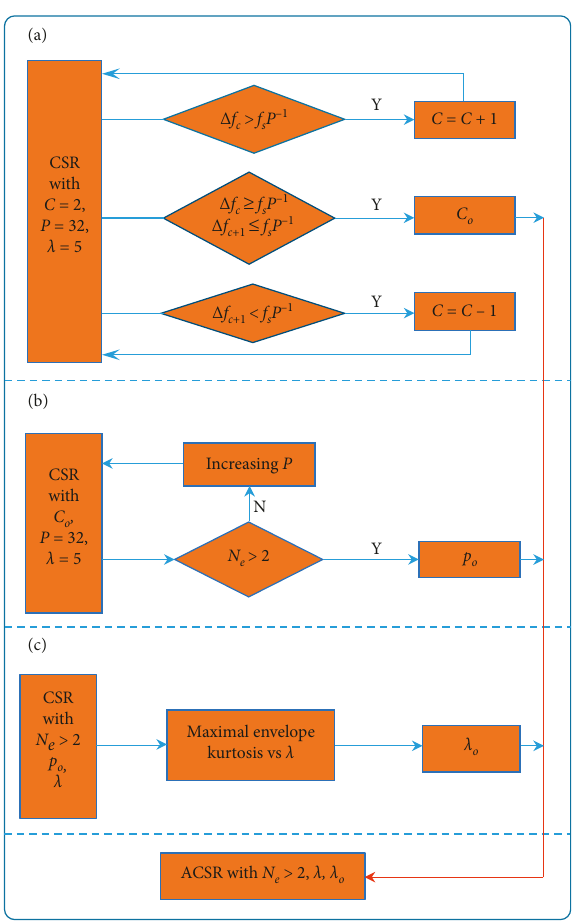
Figure 3: The procedure for the proposed ACSR. (a) Estimating the number of impulse responses. (b) Estimating the lengths of the impulse responses. (c) Estimating the regularization parameter.